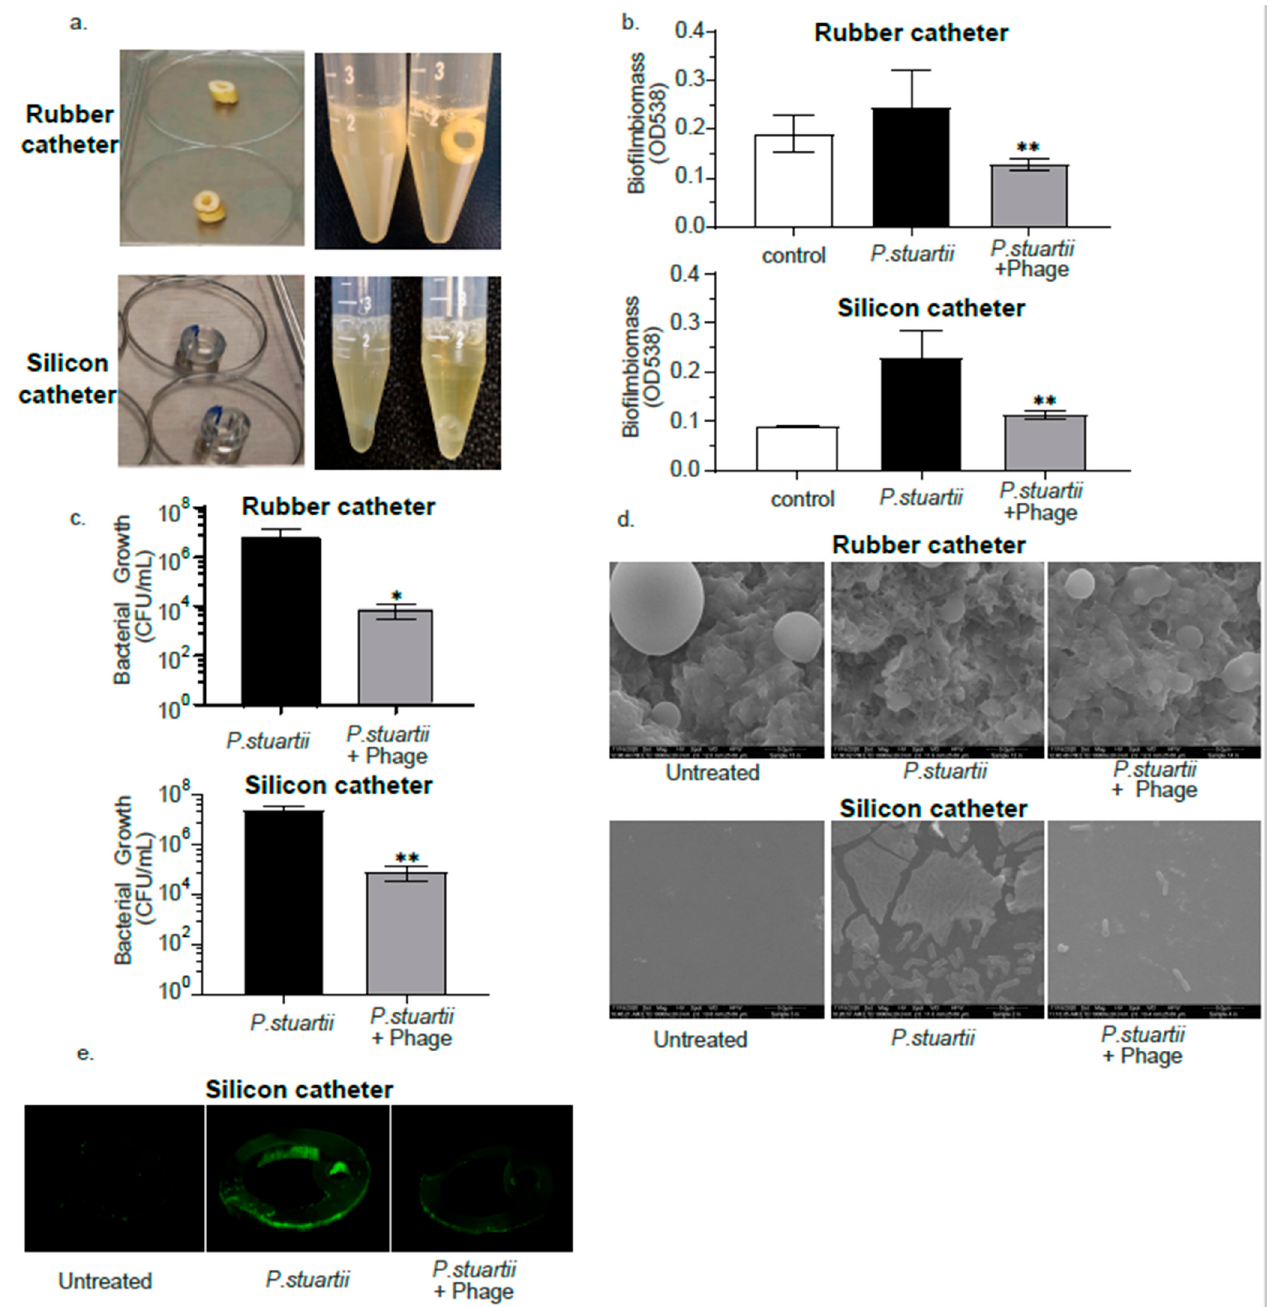
Figure 5. Biofilm degradation activity. ( a ) Model of P. stuartii biofilm formed on Latex and Silicone catheters in the absence (left tube) and presence (right tube) of phage. ( b ) Biofilm biomass quantification by crystal violet staining of P. stuartii